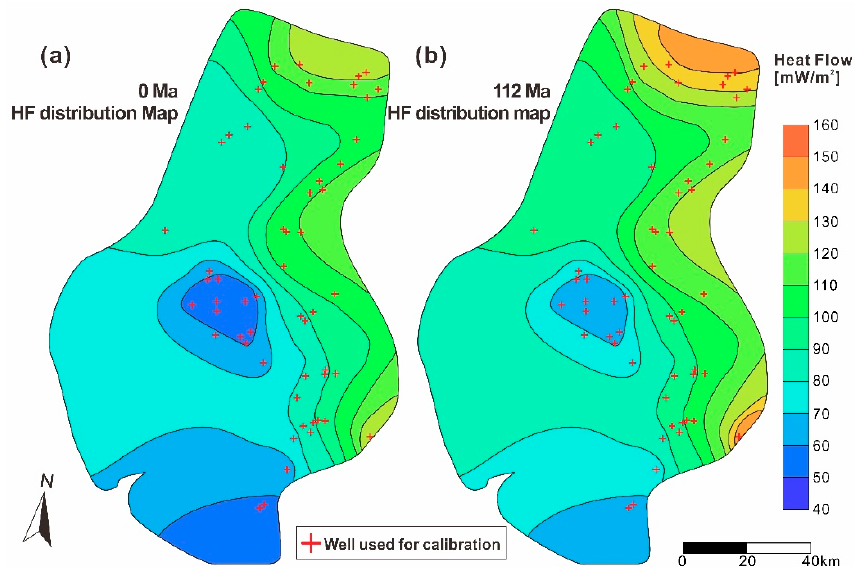
Figure 12. Heat-flow distribution definition. ( a ) Calibrated HF distribution map for the present day (0 Ma). ( b ) Calibrated HF distribution map for 112 Ma, after K 1 d deposition.